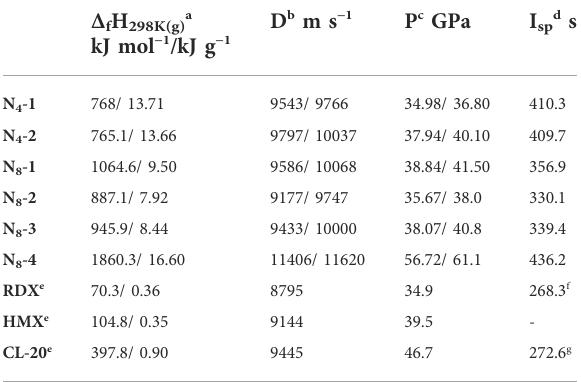
TABLE 2 Physico-chemical properties of N 4 and N 8 allotropes compared with RDX, HMX and CL-20. Δ f H 298K(g)